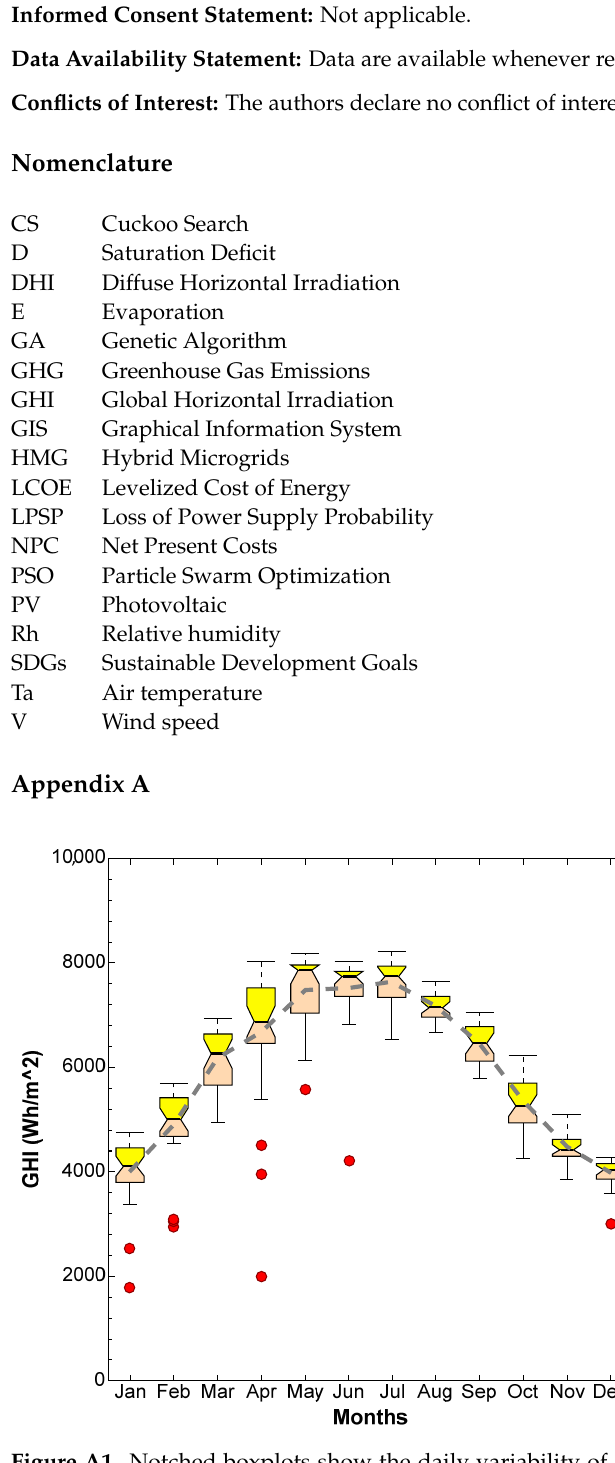
Figure A2. Notched boxplots show the daily variability of DHI for each month; the dashed line shows the mean values.